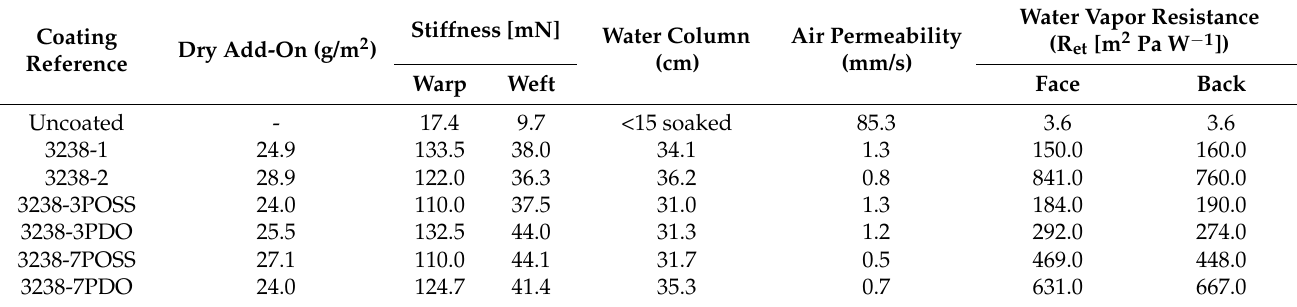
Table 8. Stiffness, water column, and air permeability of UPRON fabrics uncoated and coated by knife coating procedure.